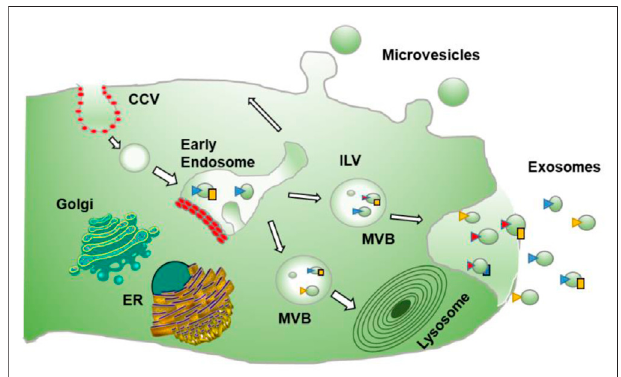
FIGURE 1 | Process of formation of Exosomes: describes the formation of exosomes which is done by invagination of late endosomal membranes within large MVBs, resulting in the development of intraluminal vesicles (ILVs). Speci fi c proteins are integrated into the invaginating membrane during this process, whereas cytosolic components are absorbed and con fi ned inside the ILVs. When ILVs fuse with the plasma membrane, they are discharged into the extracellular region, known as “ exosomes. ” While microvesicles result from direct budding from the plasma